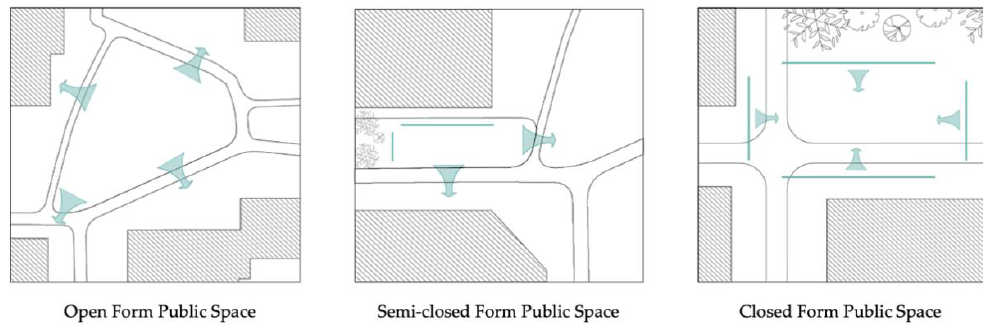
Figure 6. Social interaction among elderly women and public space sites.